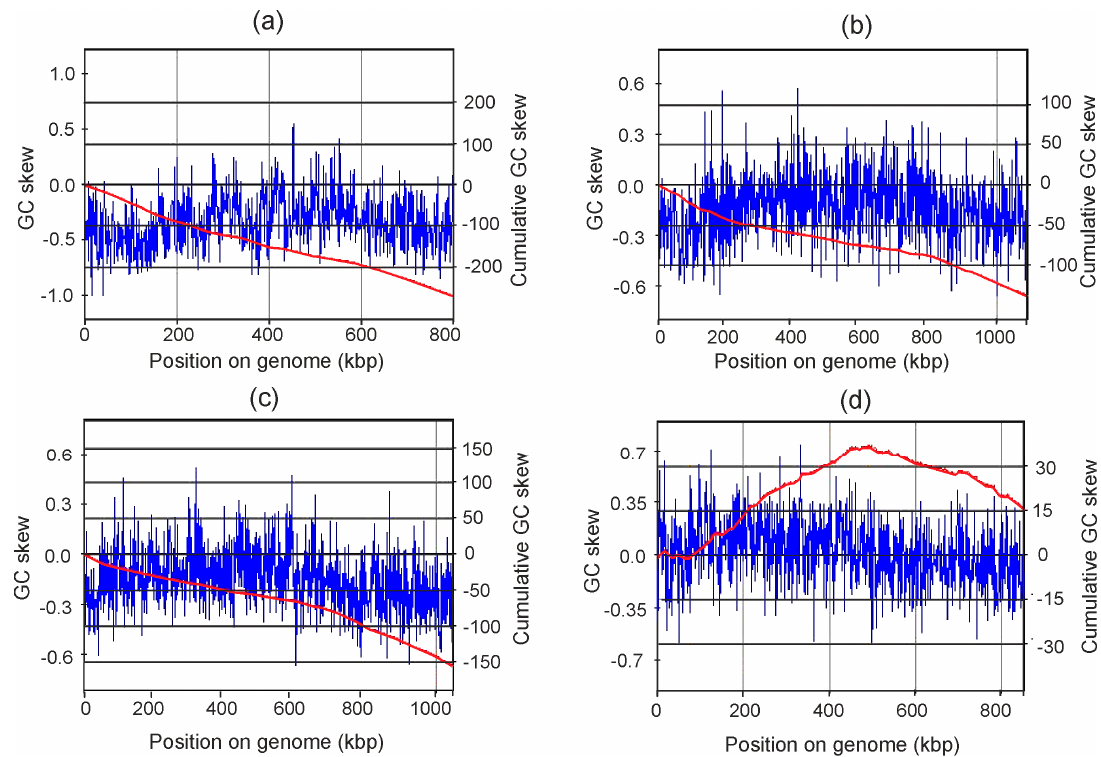
Figure 4. Diagram showing the GC skew (blue lines) and calculated cumulative GC skew (red lines) across the complete genomes of UBA1400 members: ( a ) Ch65 bacterium, ( b ) Candidatus Collierbacteria bacterium RIFOXYD2_FULL_45_13 (GenBank MFAS01000001), ( c ) Candidatus Beckwithbacteria bacterium GW2011_GWC1_49_16 (GenBank CP011210), ( d ) Bacterium GW2011_GWF2_28_16 of the candidate family PJMF01 (GenBank CP011212). Window size 10.000 nt, step size 1000 nt. Table 1. Nucleotide composition of complete genomes of members of the candidate order UBA1400. Nucleotide Composition of One Strand of DNA Genome GC Content Lineage (GenBank acc. no) Size (bp) (%)